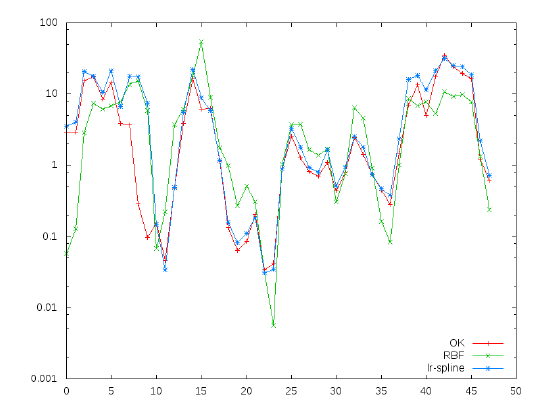
Figure 4: Leave-one-out cross validation MSE: y -axis reports the MSE [ mm 2 ] for each time step x -axis.